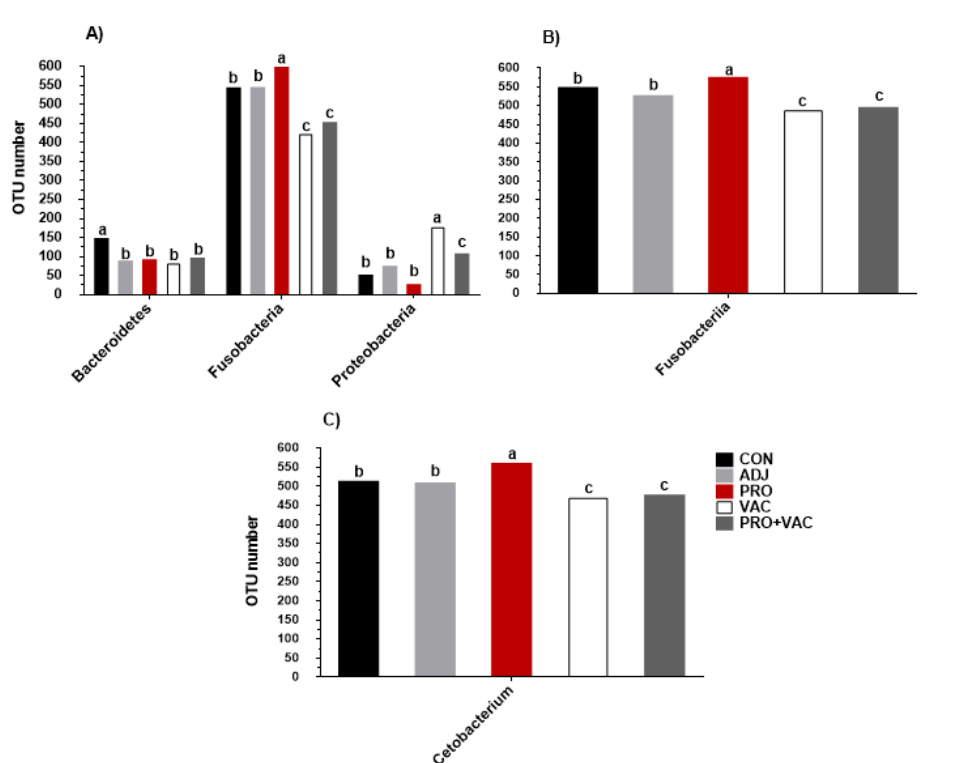
Figure 7. Taxonomic differences between treatments. Comparison of relative abundance at the bacterial phylum ( A ), class ( B ) and genus ( C ) level detected in Nile tilapia gut from the following groups: CON = control; ADJ = adjuvant; PRO = probiotics; VAC = vaccinated; PRO + VAC = probiotics + vaccine. a–c Different letters indicate significant differences ( p < 0.05) between mean values of treatments by ANOVA and post hoc Tukey–Kramer